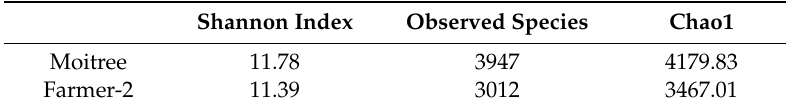
Figure 2. Principal component analysis (PCA) of rhizospheric microbes associated with lentil cultivars “Moitree” (M) and “Farmer-2” (F) under rice-fallow ecology based on shared common taxa profiles at phylum abundance variance. Table 3. Bacterial alpha diversity estimated by Shannon index, observed species, and Chao1 estimates using taxon resolution of 97% sequence similarity between lentil